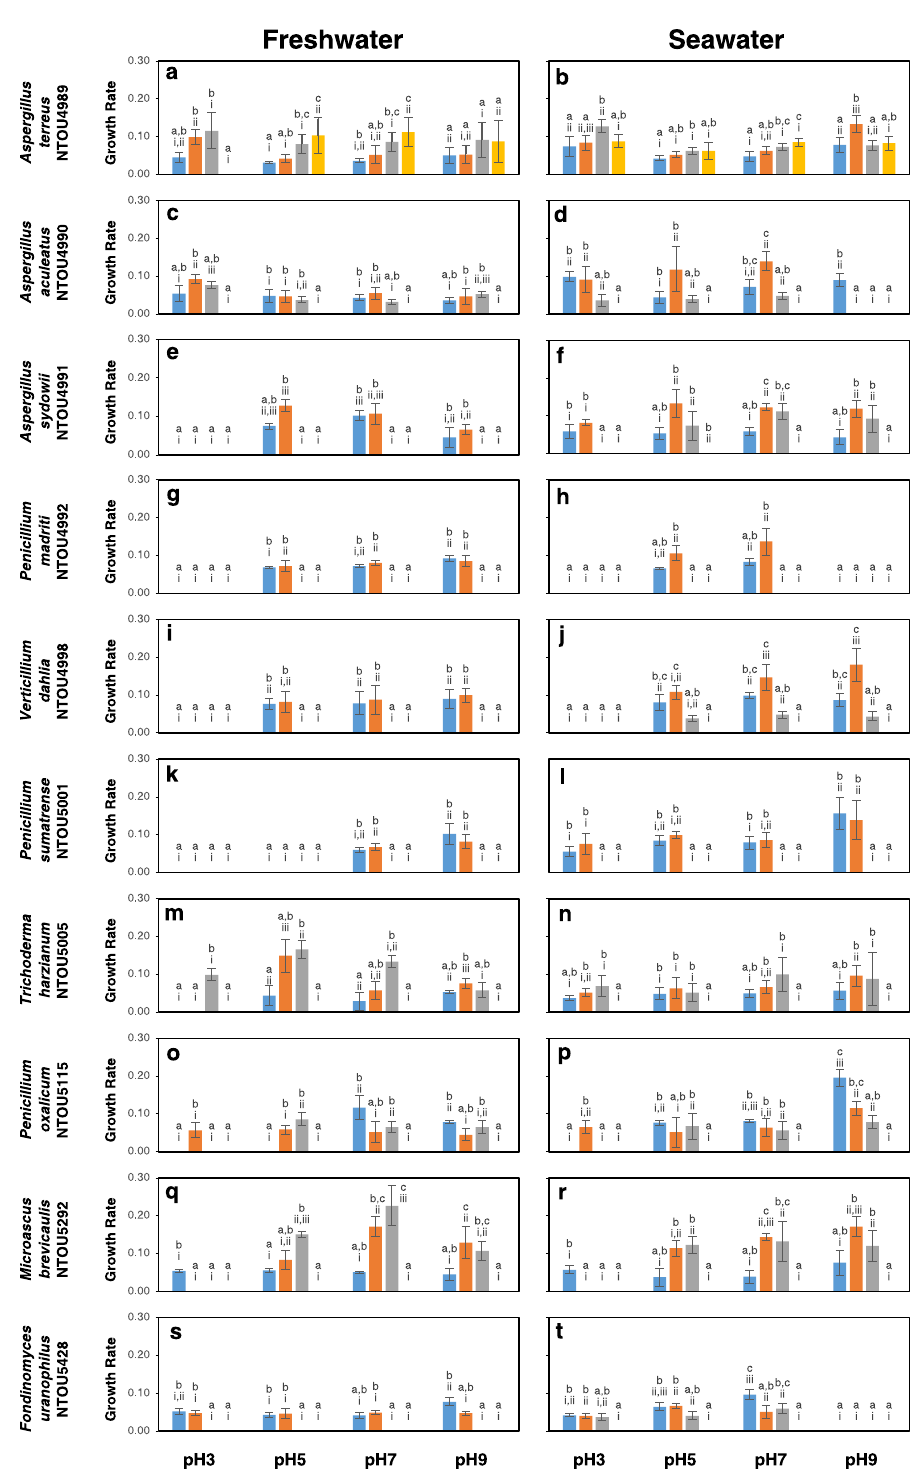
Fig 2. Normalized averaged growth rates of the tested fungal species cultured in/at 2 salinities (0‰ and 30‰), 4 pHs (pH 3, pH 5, pH 7 and pH 9) and 4 temperatures (15 ˚C, blue bar; 25 ˚C, orange bar; 37 ˚C, grey bar and 45 ˚C, yellow bar) for 30 days. Data are presented as means ± S.D. Different letters indicate significant differences between temperatures ( p < 0.05) within the same pH treatments and different Roman numerals indicate significant differences between pH within the same temperature treatments ( p <